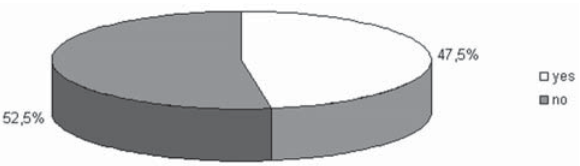
FIGURE 3- Patient distribution as to resonance modification after orthognathic surgery